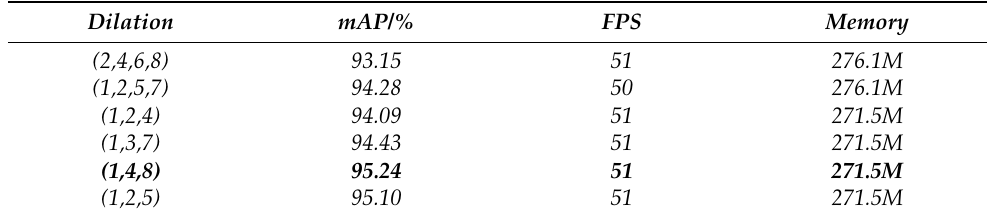
Table 4. Comparison of different dilation rates.